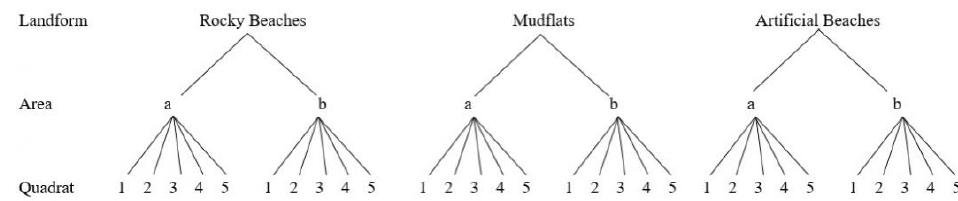
Figure 2. Structure of the sampling strategy.